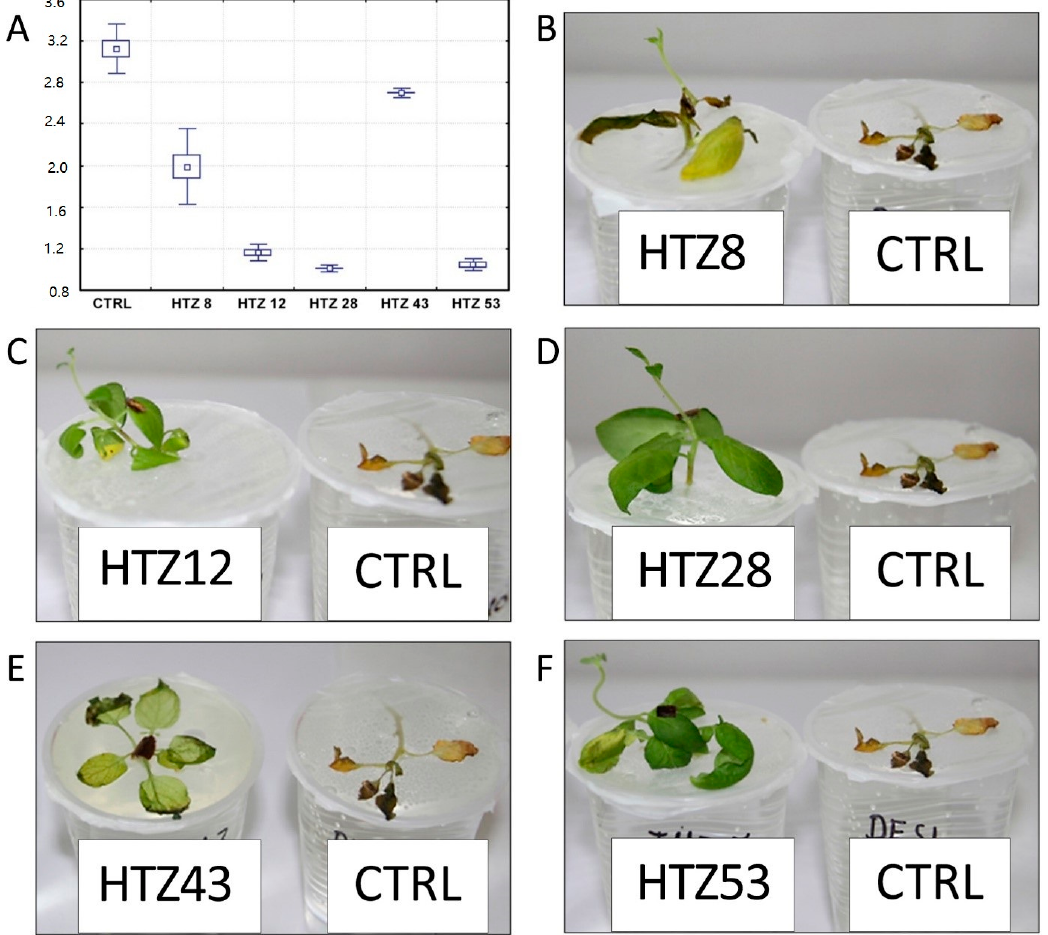
Figure 10. Degree of infection of transgenic HTZ lines with P. infestans in comparison to the non-transgenic potato (CTRL) ( A ). Sample photos of infected HTZ lines ( B – F ).